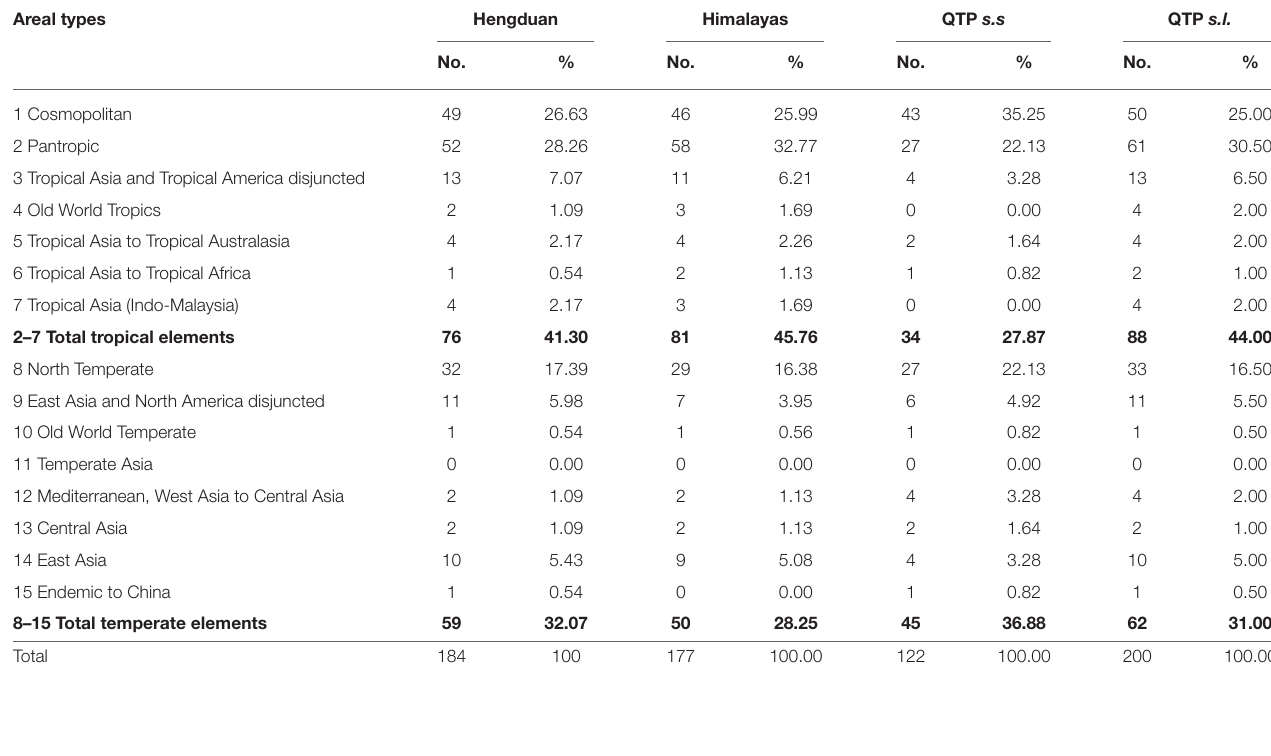
TABLE 5 | Geographical elements of seed plants of the Hengduan Mountains, the Himalayas, the Qinghai-Tibet Plateau s.s. , and the Qinghai-Tibet Plateau s.l. at the family level. Areal types